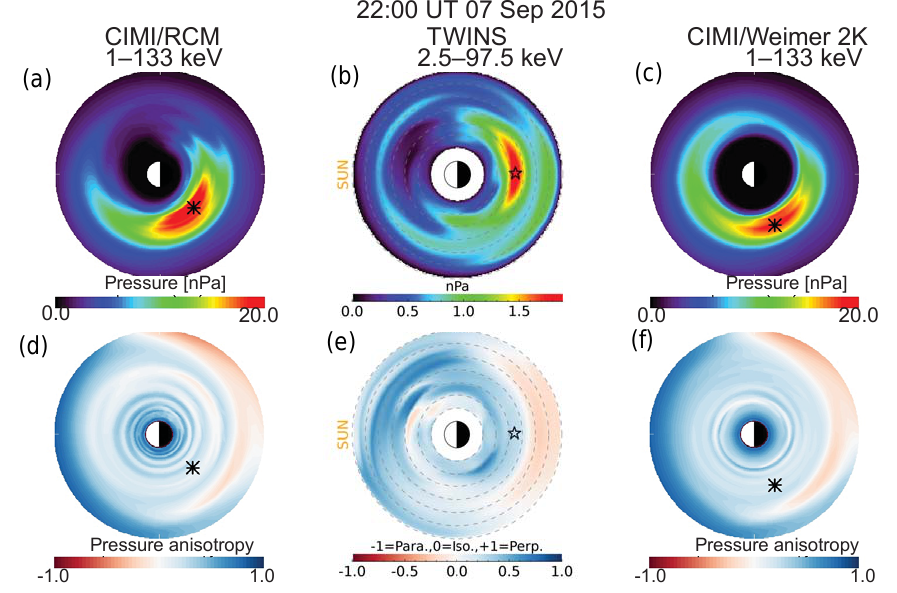
Figure 3. The ion equatorial pressure (a–c) and pressure anisotropy (d–f) for 22:00UT 7 September 2015 from the CIMI/RCM simulations (a, d) , from the TWINS ENA images (b, e) , and the CIMI/Weimer simulations (c, f) . The stars mark the locations of the